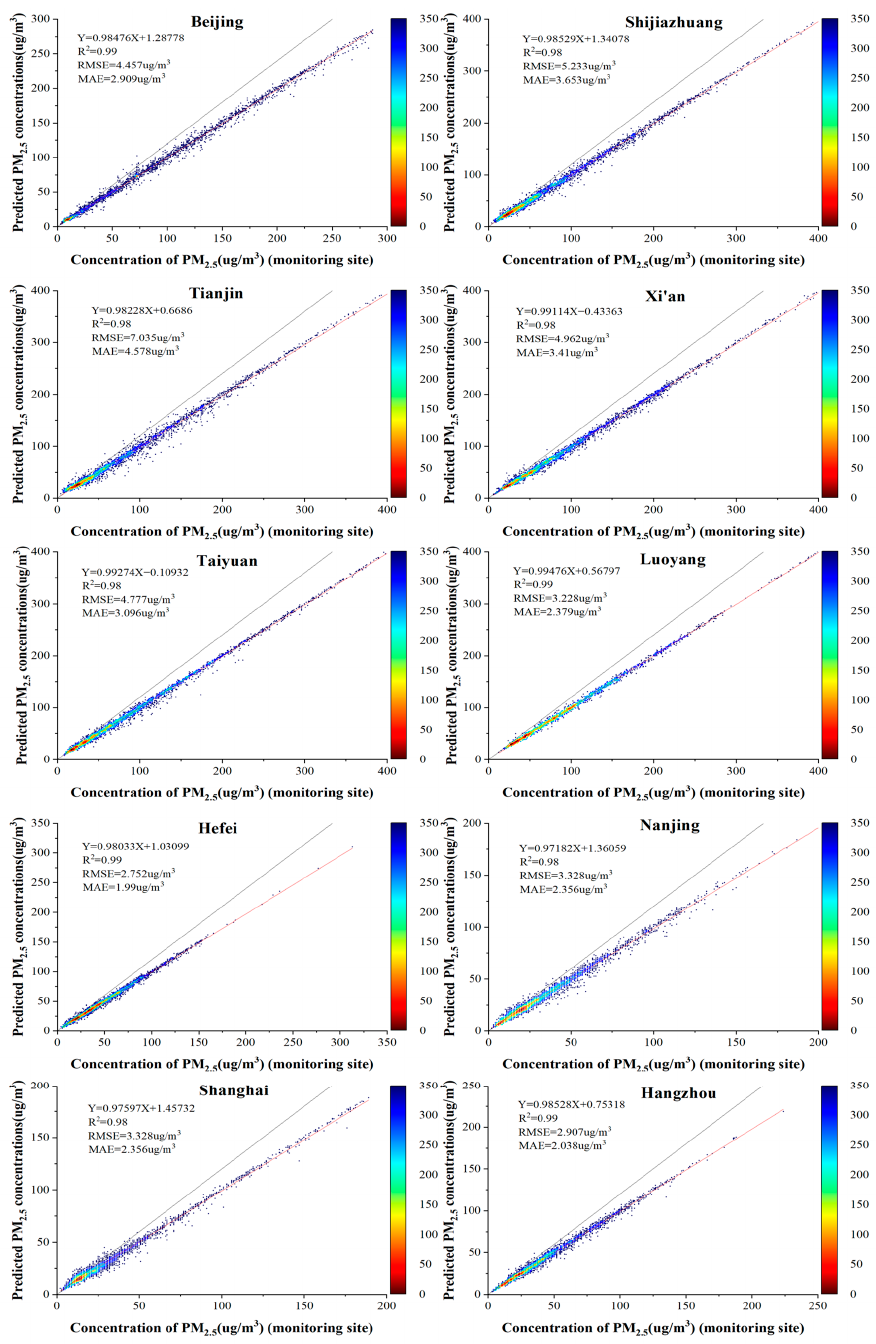
Figure 9. Scatter plot of model results for the 10 cities in the heavily polluted areas based on the LUR ‐ GBM model.